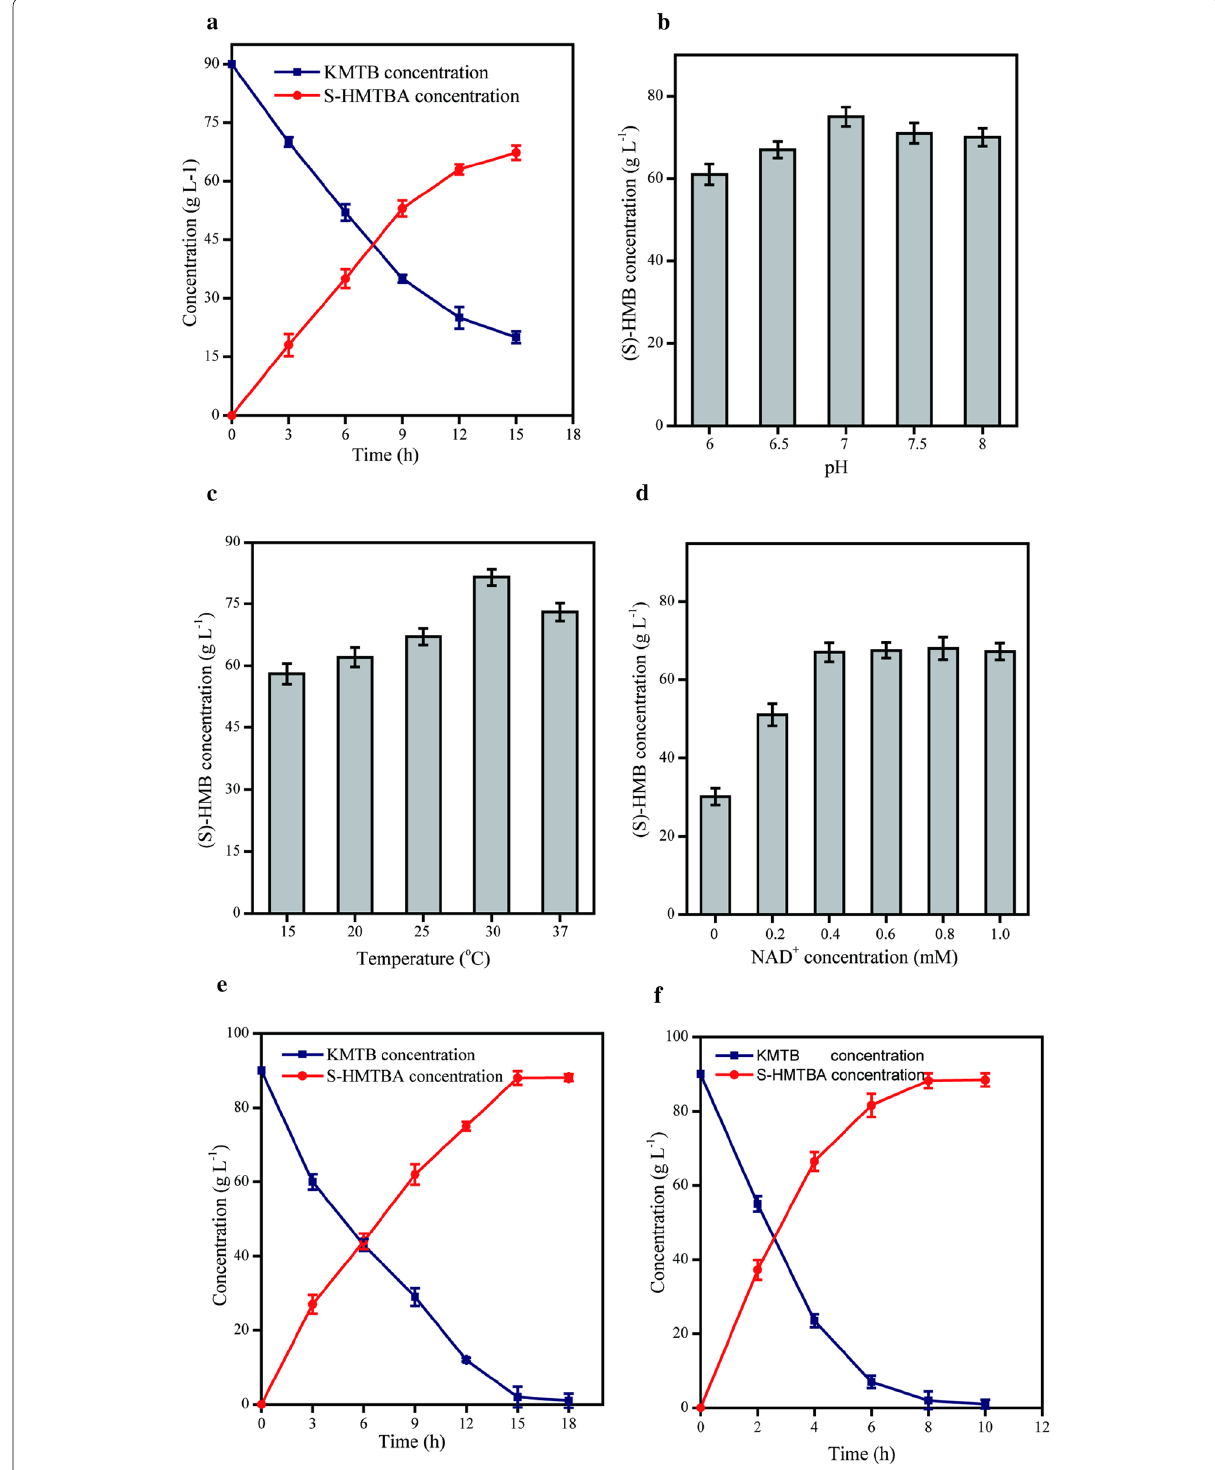
Fig. 4 Optimization of EM2. a Time courses of the initial conditions: wet biomass of S-selective whole-cell catalyst (20 g L − 1 ) in KP buffer (50 mM, pH 6.5, 1 mM NAD + ) containing the KMTB (90 g L − 1 ) and sodium formate (125 g L − 1 ), at 200 rpm and 25 °C. b Effects of different pH on ( S )-HMTBA production. c Effects of different temperatures on ( S )-HMTBA production. d Effects of NAD + concentration on ( S )-HMTBA production. e Time course of the optimized conditions: wet biomass of S-selective whole-cell catalyst (20 g L − 1 ) in KP buffer (50 mM, pH 7.0, 0.4 mM NAD + ) containing the KMTB (90 g L − 1 ) and sodium formate (125 g L − 1 ), at 200 rpm and 30 °C at 20-mL scale. f Time course of the optimized conditions at 1-L